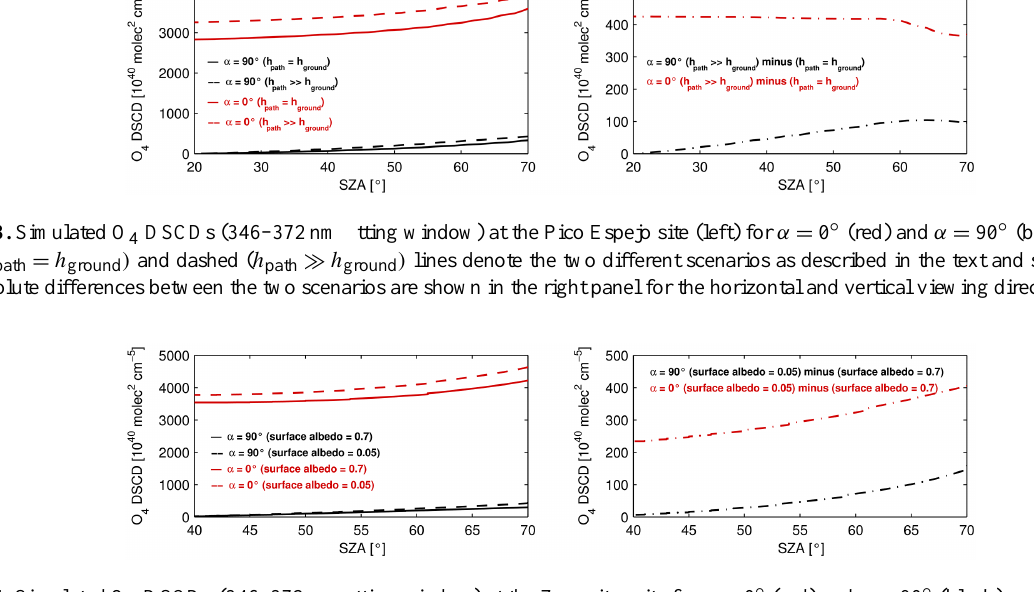
Figure 4. Simulated O 4 DSCDs (346–372nm fitting window) at the Zugspitze site for α = 0 ◦ (red) and α = 90 ◦ (black) assuming a surface albedo of 0.05 (solid line) and 0.7 (dashed line). The absolute differences between the two scenarios are shown in the right panel for the horizontal and vertical viewing direction.